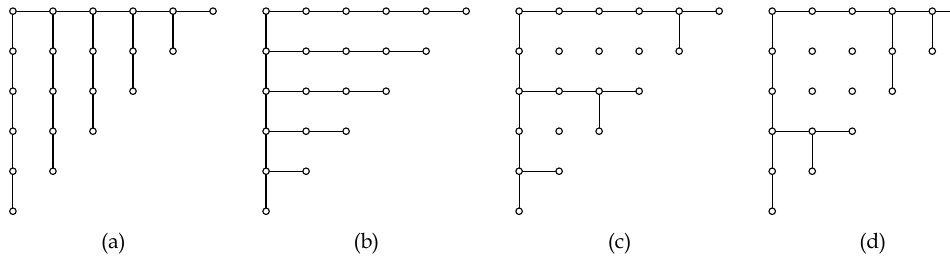
Figure 4. Strategies for performing large degree isogeny evaluation comprised of 6 small degree isogenies. Horizontal lines represent l -isogeny evaluations of points. Vertical lines stand for l scalar point multiplications. ( a ) Multiplication-based strategy, ( b ) isogeny-based strategy, ( c ) optimal serial strategy with a more expensive point multiplication, and ( d ) optimal serial strategy with a more costly isogeny